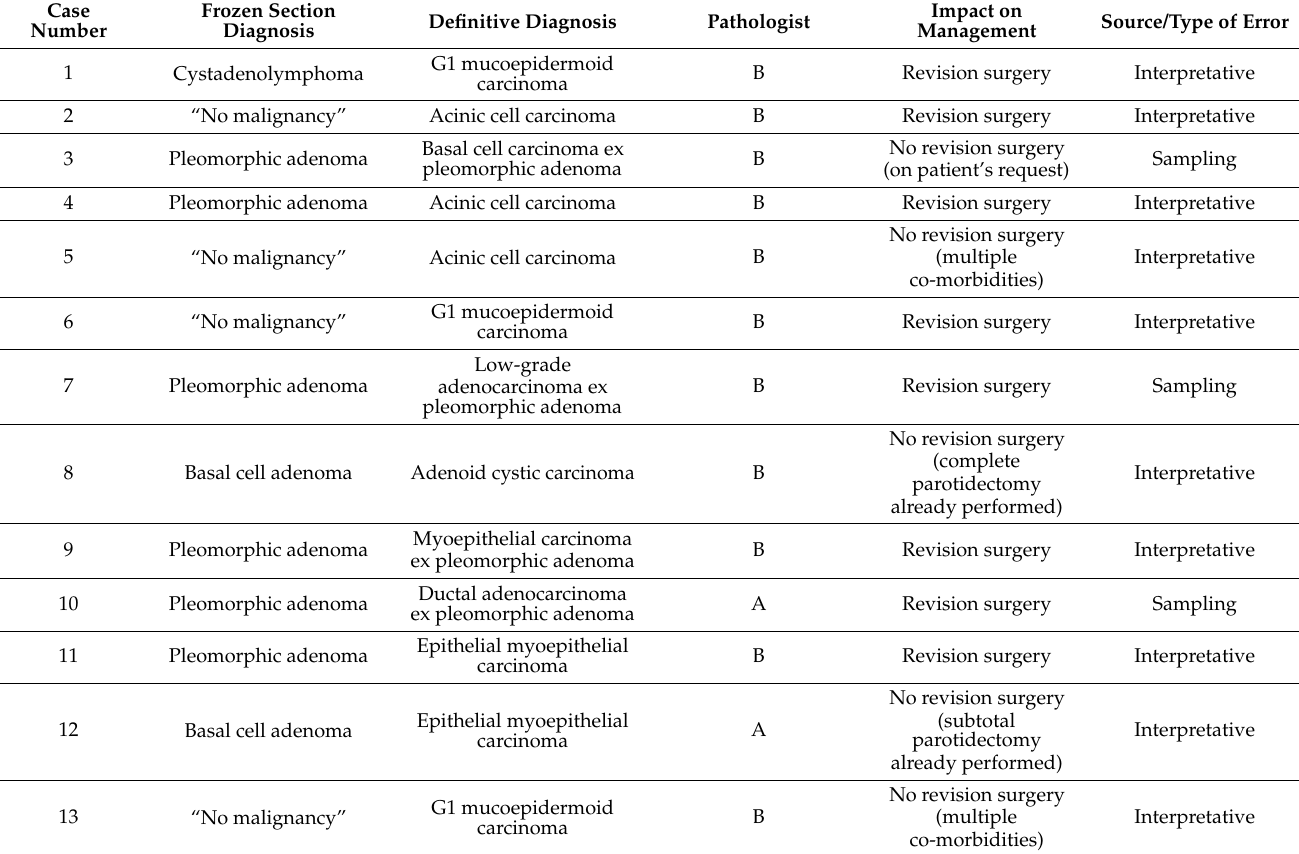
Table 1. Detailed demonstration of the study cases with discordance in the identification of the malignant nature of entity between frozen section and final diagnosis (A: experienced head and neck pathologist, B: averagely experienced